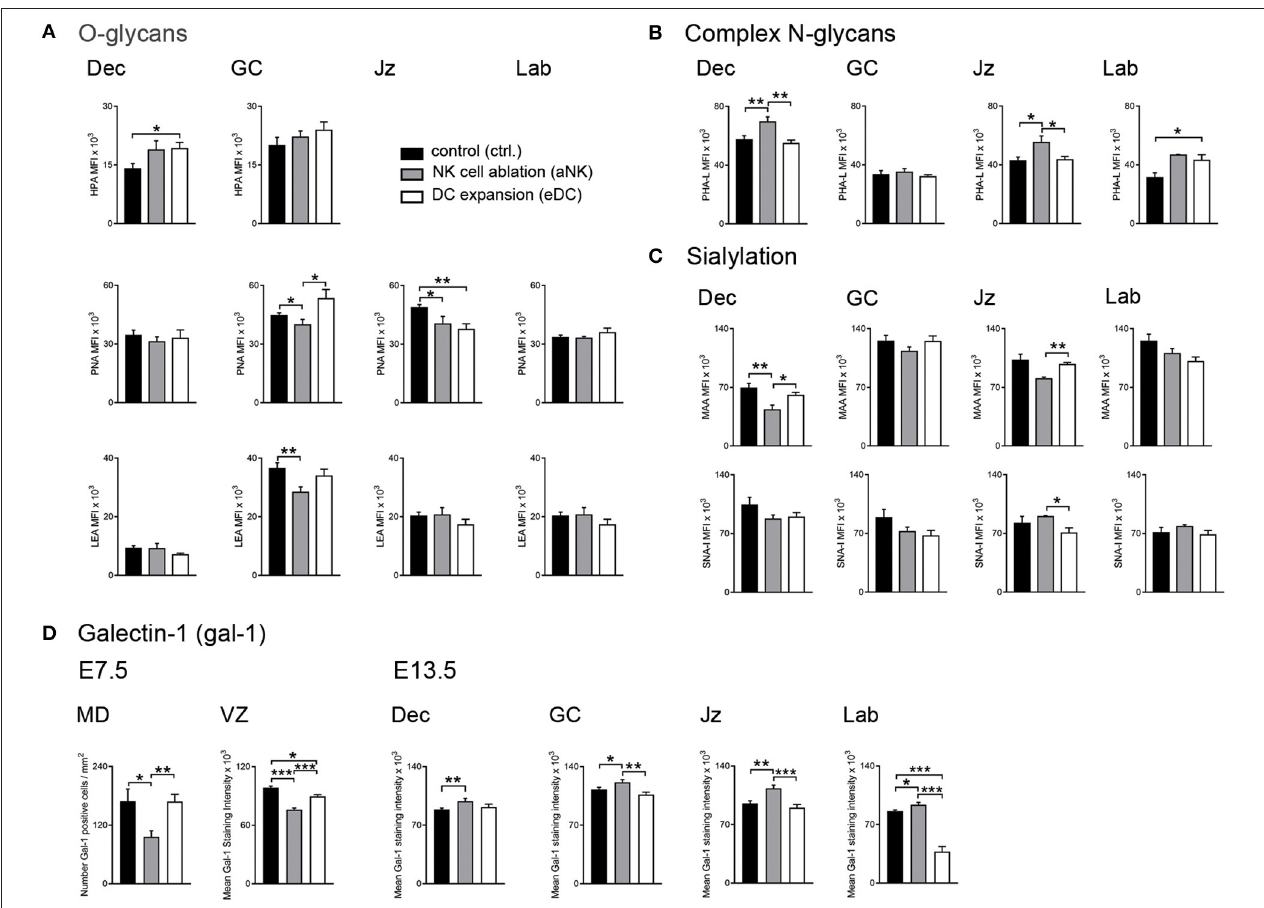
FIGURE 2 | Placental glycocode dynamics upon NK cell depletion and DC expansion during early gestation. (A) Quantification of O-glycan distribution across decidua and placenta layers on E13.5. Tn antigen was identified using the Helix pomatia agglutinin (HPA), core 1 and core 2 O-glycans were detected by Arachis hypogaea lectin (PNA) and L ycopersicon esculentum lectin (LEA), respectively. (B) Expression patterns of complex N-glycans were detected by Phaseolus vulgaris lectin (PHA-L) on E13.5. (C) Sialylation in the post-placentation period was characterized using Maackia amurensis lectin (MAA) and Sambucus nigra agglutinin (SNA-I) which bind to α 2,3- and α 2,6-linked sialic acid, respectively. (D) Analysis of galectin-1 (gal-1) expression during the pre- (E7.5) and post-placentation (E13.5) period. In all panels, bars show the MFI mean values and the corresponding S.E.M. Differences are noted as * P < 0.05, ** P < 0.01, and *** P < 0.001 according to Mann-Whitney U-test . MFI, mean fluorescence intensity; MD, mesometrial decidua; VZ, vascular zone; GC, giant cells; Jz, junctional zone; Lab, labyrinth.